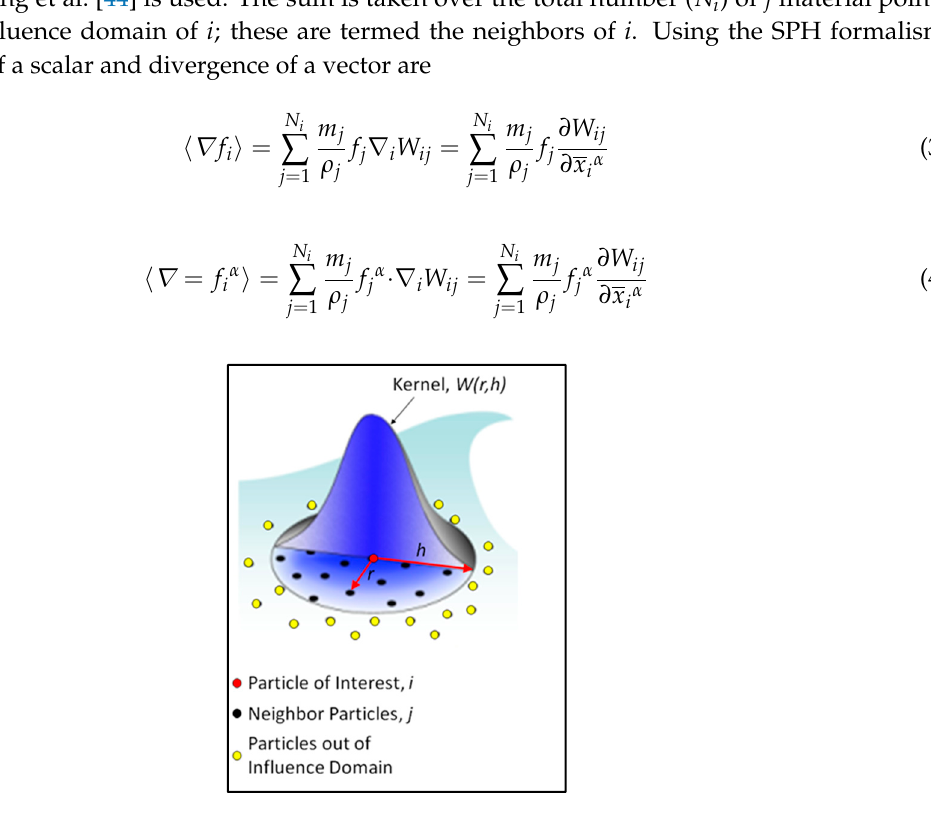
Figure 1. Interpolation in the smoothed particle hydrodynamics method (SPH). Reproduced from [36].